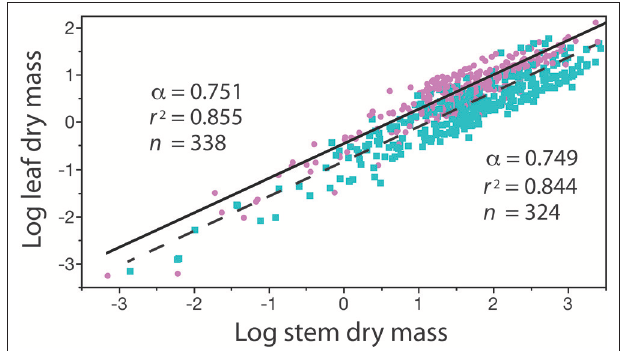
FIGURE 5 | Bivariate plot (and regression parameters) of log 10 -transformed standing leaf dry mass vs. standing stem dry mass (original units in kg) for conifers (purple circles) and angiosperms (blue squares) with corresponding solid and dashed regression curves. This example shows that differences in the numerical values of β indicate that, for any stem diameter, conifers bear more dry leaf mass than their angiosperm counterparts. See text for scaling formulas. Data taken from the Cannell (1982) worldwide